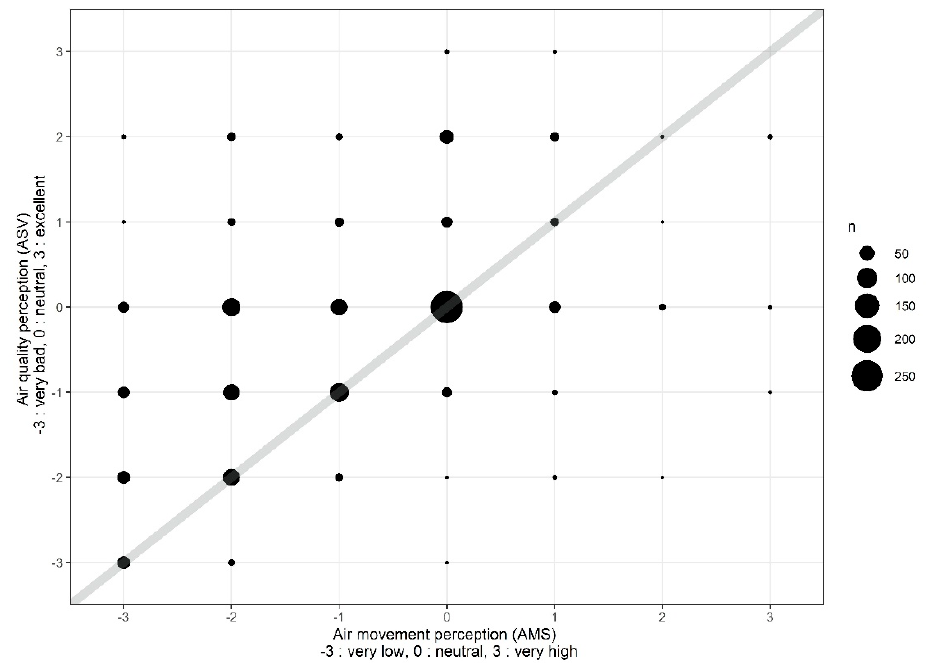
Figure 8. Comparison of agreement between air movement and air quality perception vote results for Stage 2 (the number of responses n is proportional to the area of circles).